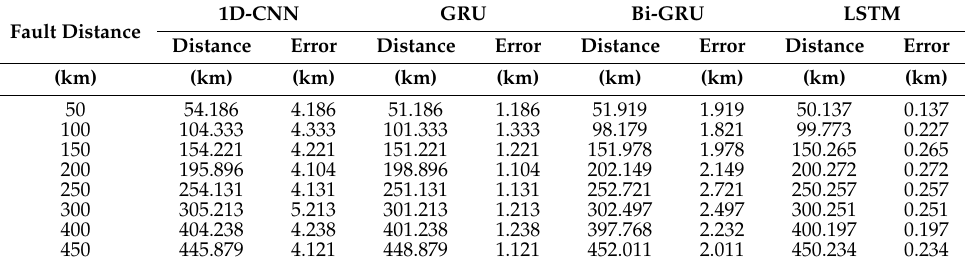
Table 3. Comparison of different regression algorithms.